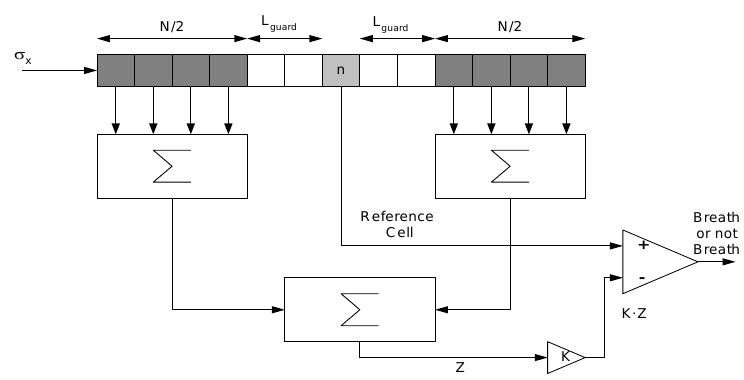
Figure 5. CFAR processor for breathing